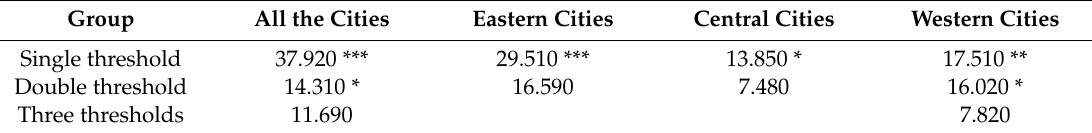
Table 6. Threshold e ff ect test.